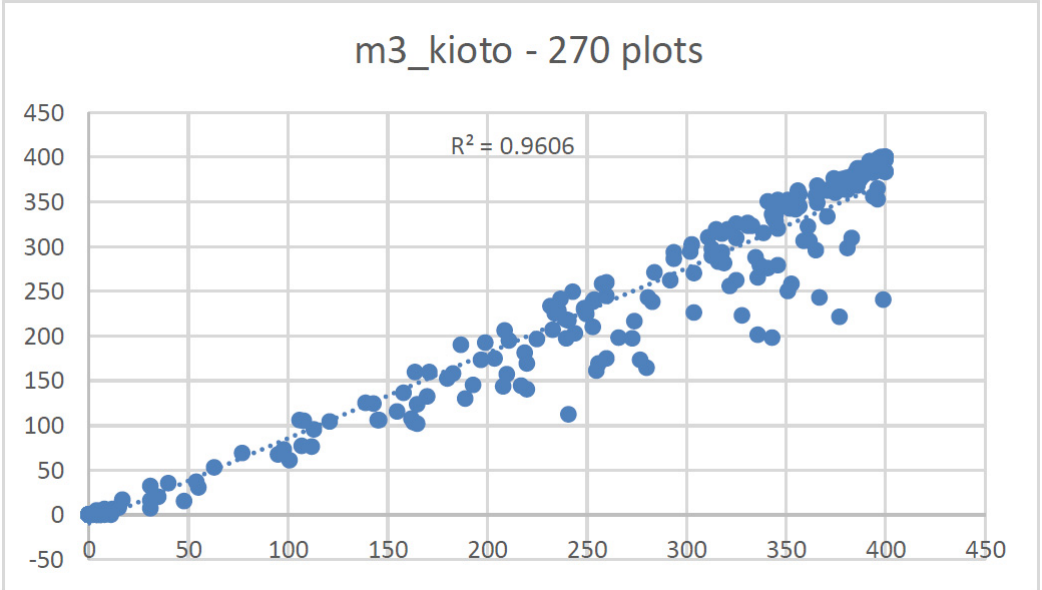
Figure A12. Reference area compared to estimated forest area by Method 1 for test plots (10 × 10 m 2 ) as defined by the UNFCCC.